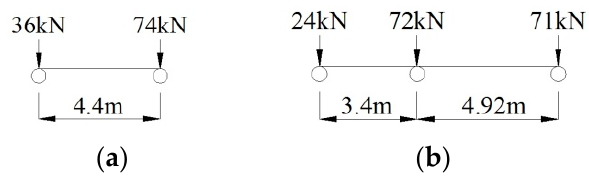
Figure 5. Simplified fatigue-load vehicle model. ( a ) Model M 1 . ( b ) Model M 2 .